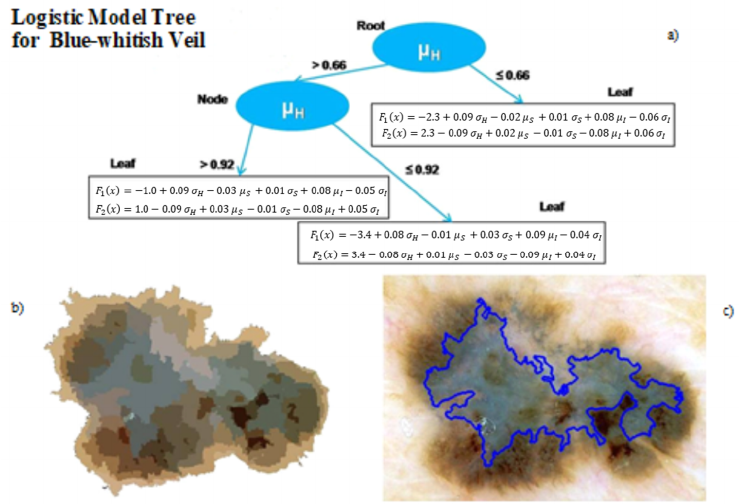
Figure 2. Detection of the blue-whitish veil: ( a ) Logistic model tree with regression models Fi(x) (with i = 1, blue-veil region, and i = 2, no blue-veil region); ( b ) lesion map (feature extraction); ( c ) regions classified as blue-whitish veil.